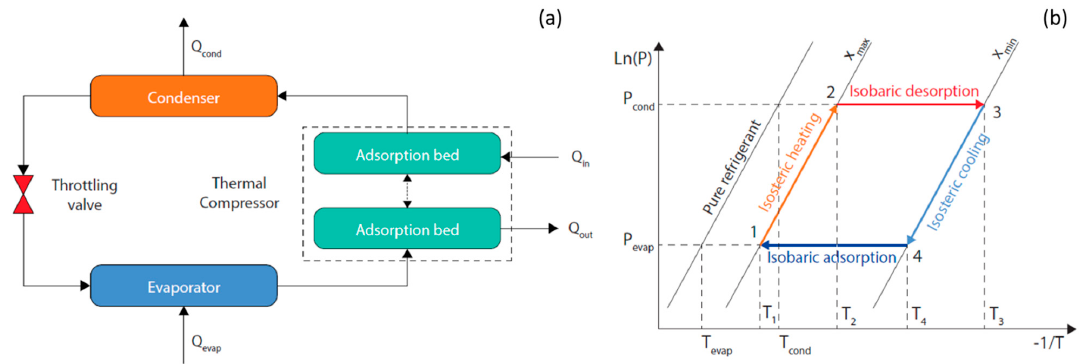
Figure 1. Schematic ( a ) and P-T-x cycle diagram ( b ) of a conventional adsorption refrigeration process .